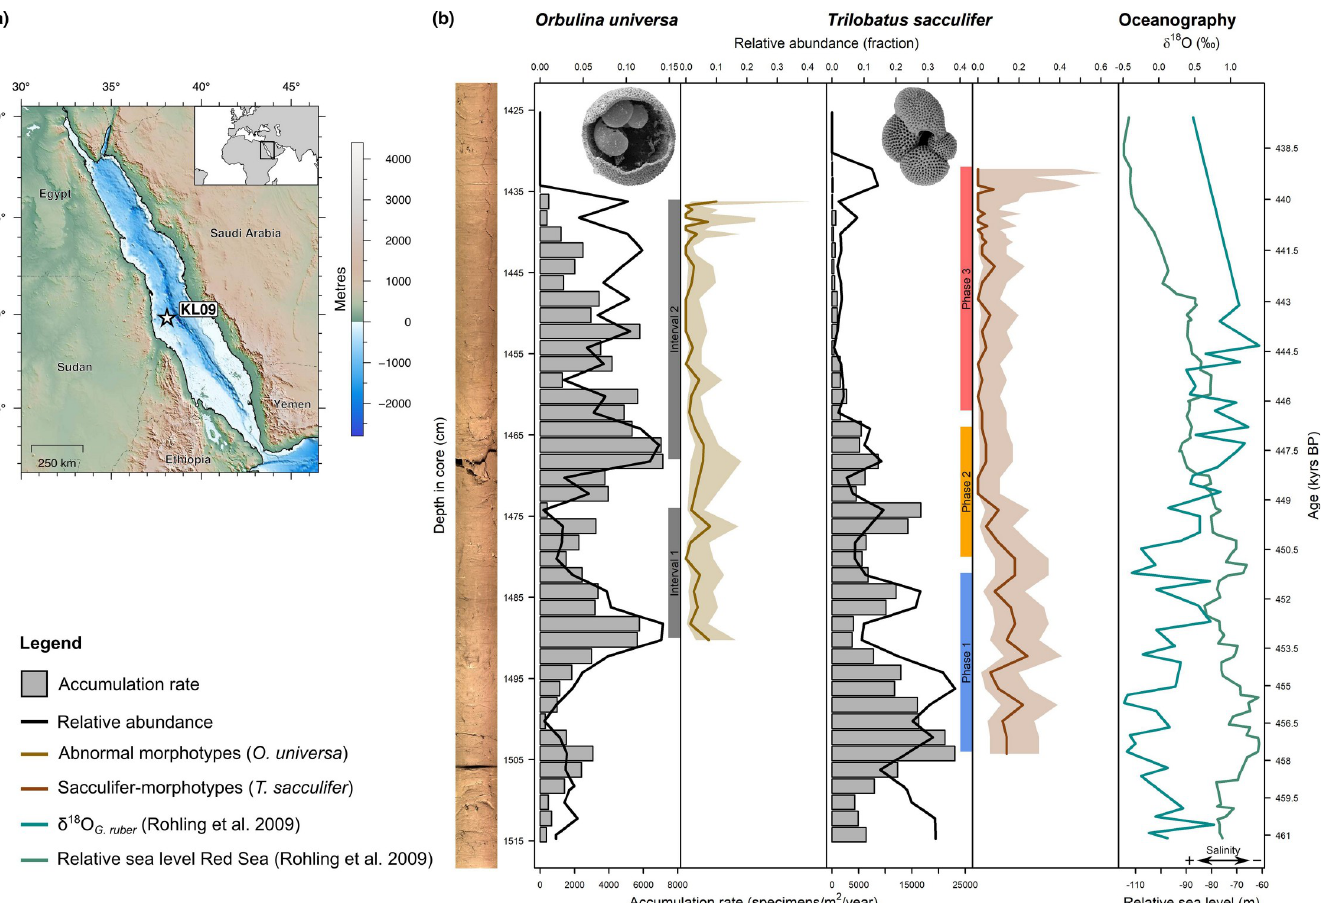
Fig 1. Summary of the sampling material from piston core Geo-TU¨ KL09. (a) Map of the sampling area with indication of the core position. (b) Stratigraphic plot with core image. Accumulation rates, relative abundances in relation to other species of planktonic Foraminifera, and the incidence of abnormal morphotypes in Orbulina universa and sacculifer-morphotypes in Trilobatus sacculifer is indicated (shaded area depicts 95% confidence intervals). The aplanktonic zone begins at approximately 438 kyrs BP. The two intervals of dropping abundance for O . universa (Intervals 1 and 2) and the three phases defined for T . sacculifer (Phases 1–3) based on relative abundances are indicated. The δ 18 O G. ruber measurements and the three-point moving average relative sea level in the Red Sea [26] is also shown. Example scanning electron microscope images of the two investigated species are shown in the respective panels. The O . universa specimen was cracked open to reveal the juvenile shell inside. Image of T . sacculifer from Hesemann